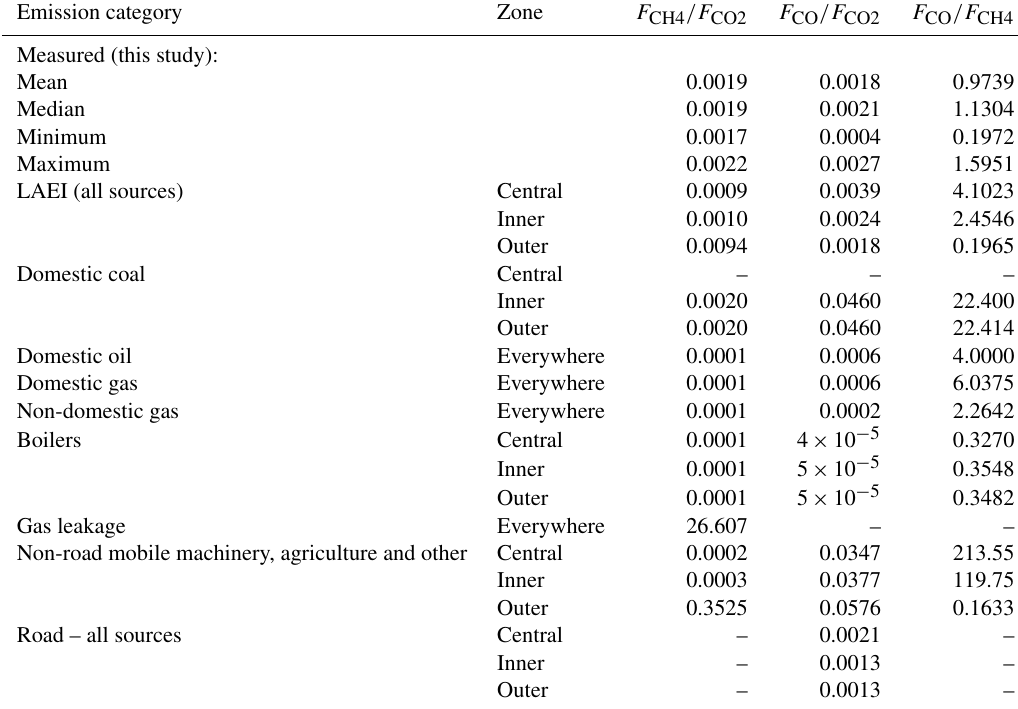
Table 2. Emission ratios from measurements and the London Atmospheric Emissions Inventory (LAEI). Measured quantities are mean, median and range of monthly emissions segregated by wind